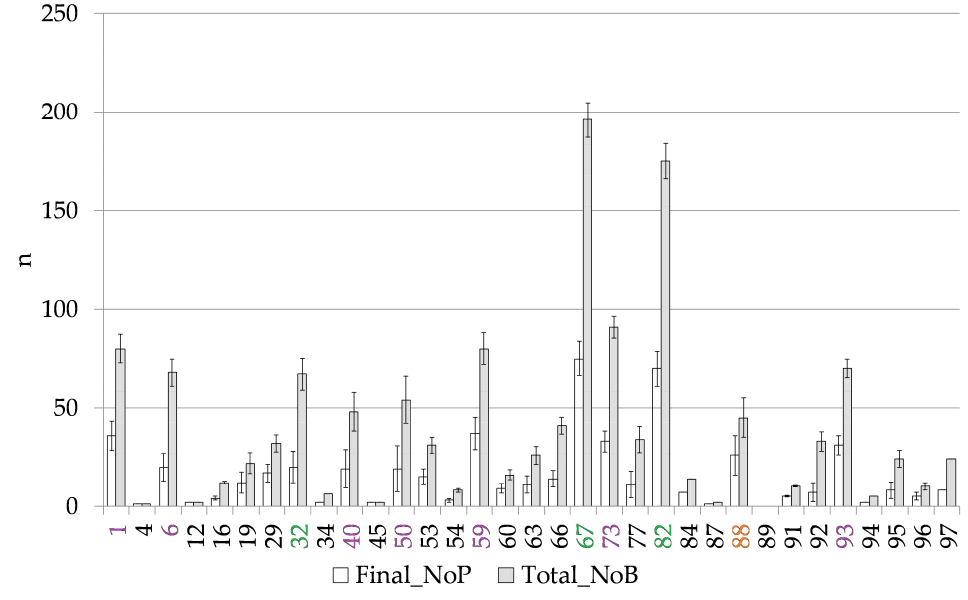
Figure 2. Final_NoP (final number of pods) and Total_NoB (total number of beans) for each genotype at the end of the 2018 heat stress trial. Genotypes with a higher Total_NoB in 2018 than the reference variety Bonela (orange, 88) are colored in purple, while genotypes 32, 67 and 82 that developed more beans than Bonela in 2018 and 2020 are marked in green (cf. Figure 3).